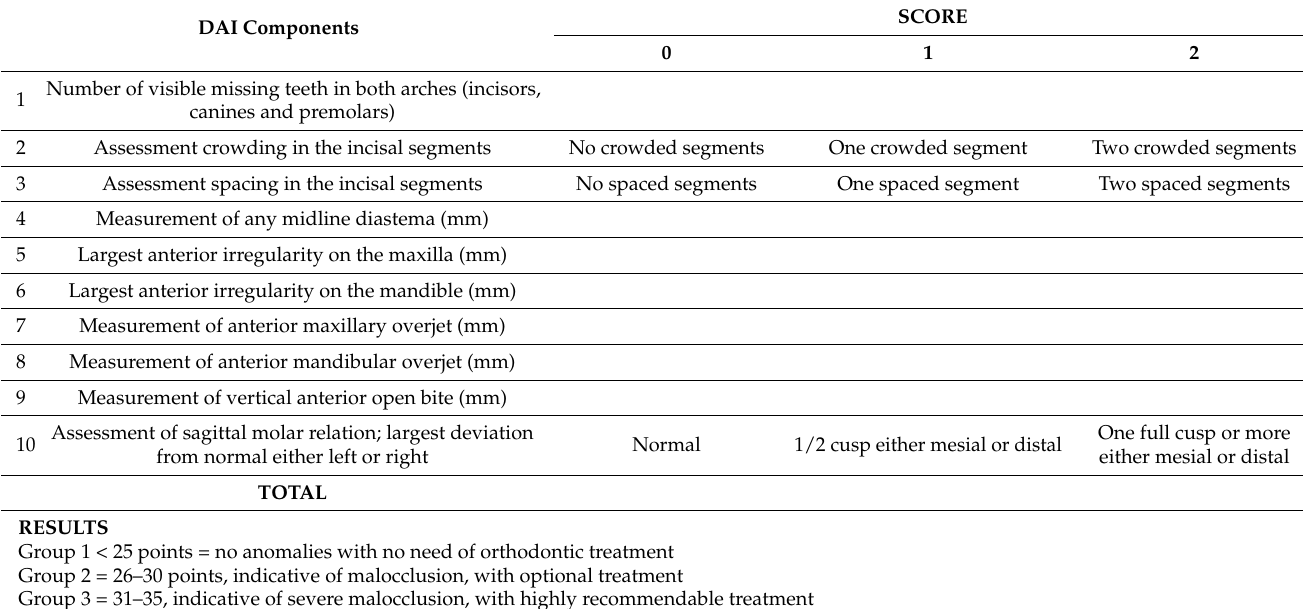
Table 2. Dental Aesthetic Index (DAI) 10 components. Groups by final